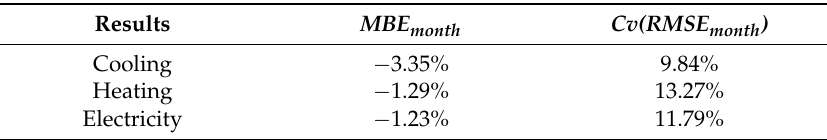
Table 6. Calibration results.